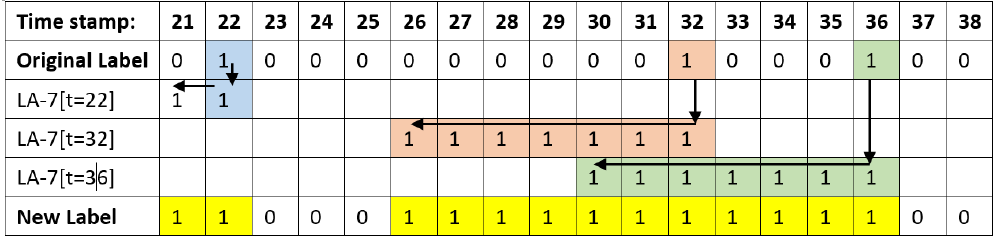
Figure 7. New Labels generation with LA-7.